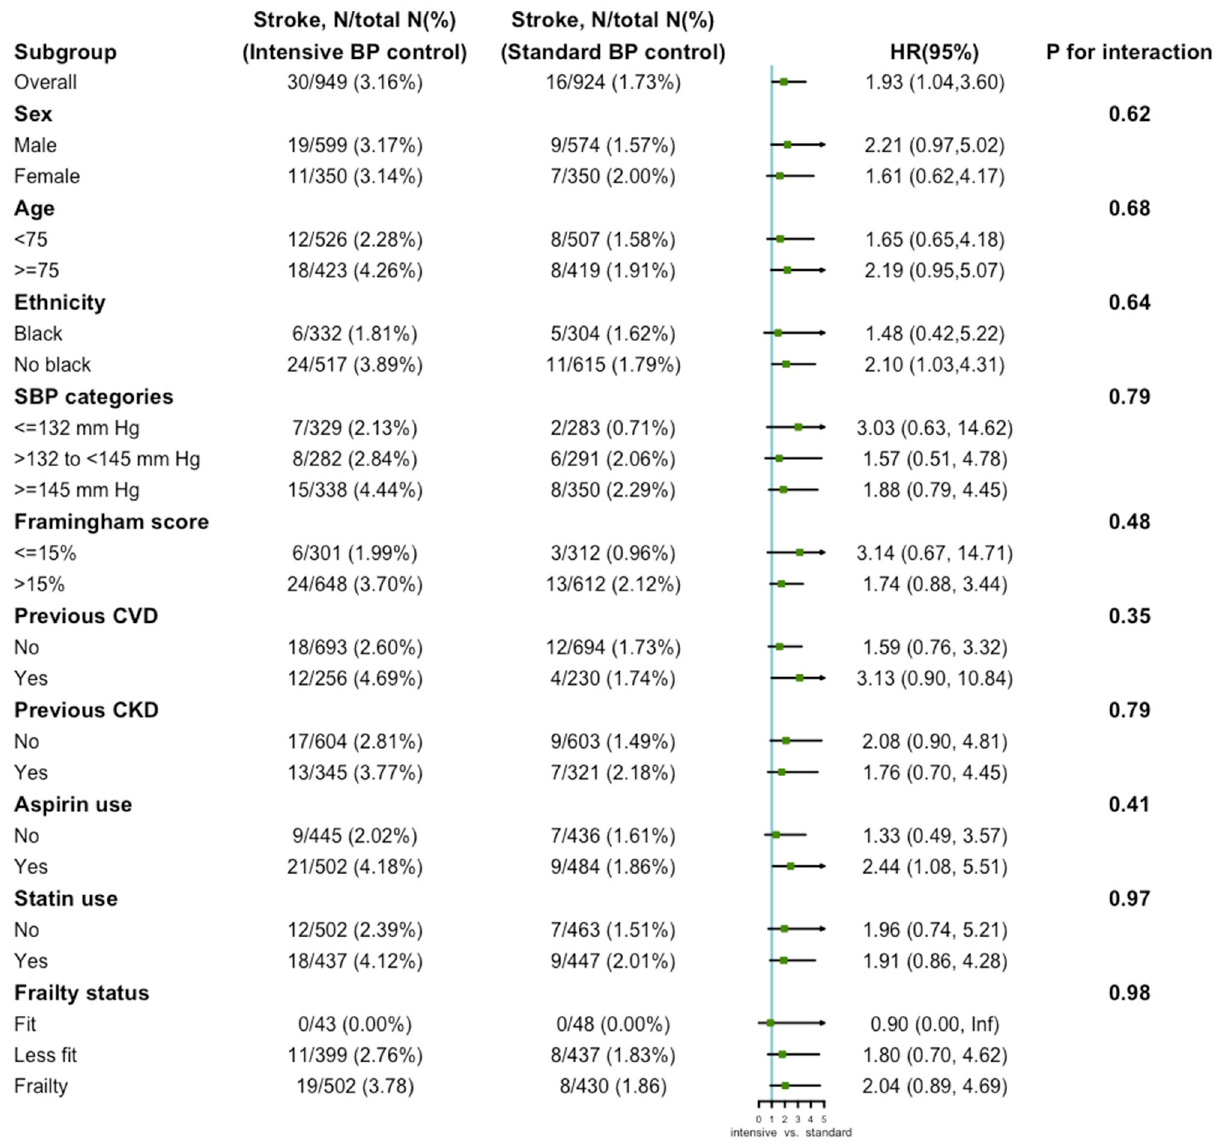
FIGURE 2 | Subgroup analysis of the association between the treatment arms and stroke in lower cognitive function group. Each subgroup analysis was adjusted for all factors in Model 3, except for the stratification factor